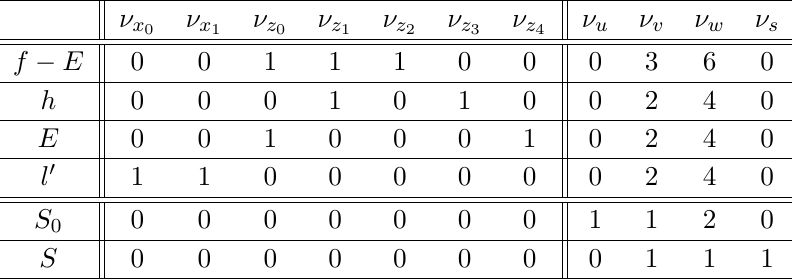
fibration over B 3 = dP 2 × P 1 . 112 l 0